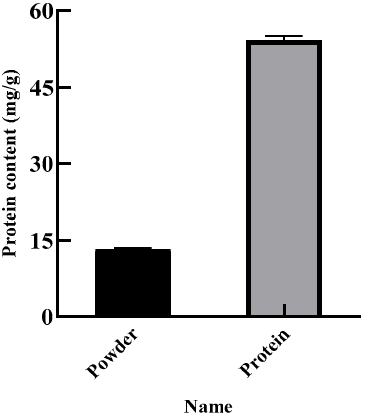
Figure 8. Effect of pH on the optical density of the supernate.